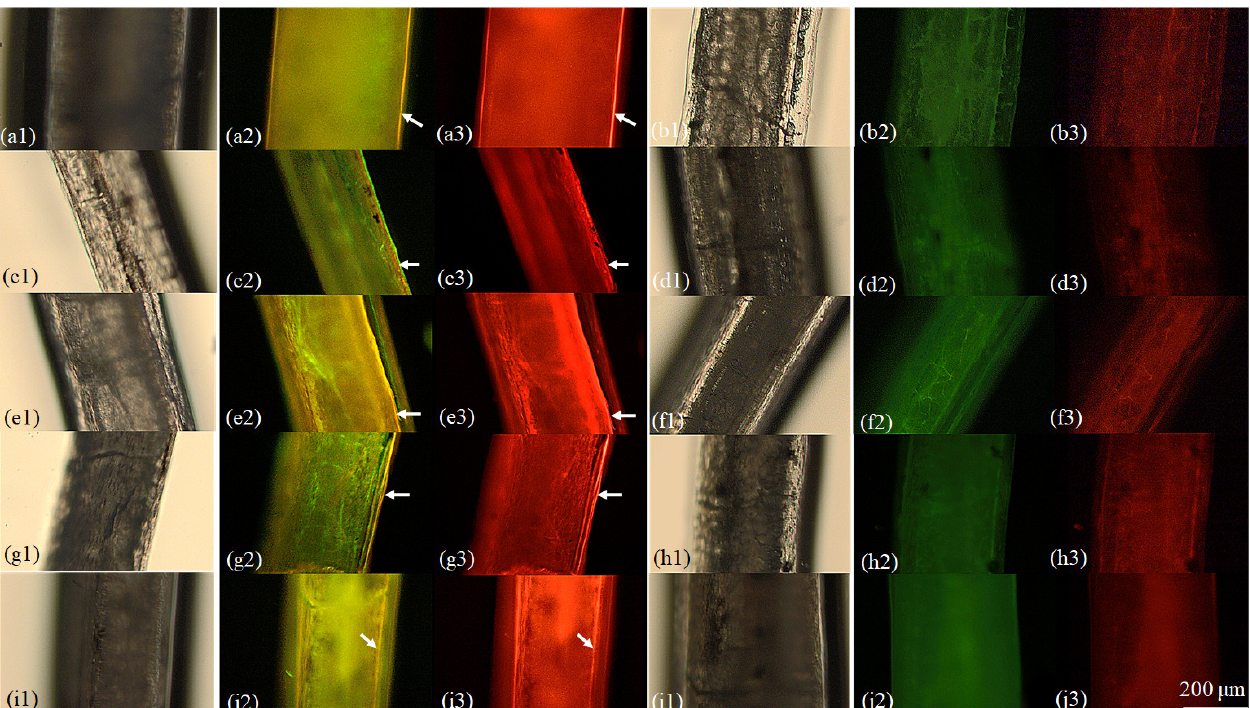
Figure 3. The typical patterns of marking when alizarin complexone (ALC) is used for marking fin rays in juvenile silver carp, Hypophthalmichthys molitrix . Note: ( a1 ), ALC-marked pectoral fin rays under transmitted light; ( a2 ), ALC-marked pectoral fin rays under blue excitation light; ( a3 ), ALC- marked pectoral fin rays under green excitation light; ( b1 ), control pectoral fin rays under transmitted light; ( b2 ), control pectoral fin rays under blue excitation light; ( b3 ), control pectoral fin rays under green excitation light; ( c1 ), ALC-marked dorsal fin rays under transmitted light; ( c2 ), ALC-marked dorsal fin rays under blue excitation light; ( c3 ), ALC-marked dorsal fin rays under green excitation light; ( d1 ), control dorsal fin rays under transmitted light; ( d2 ), control dorsal fin rays under blue excitation light; ( d3 ), control dorsal fin rays under green excitation light; ( e1 ), ALC-marked ventral fin rays under transmitted light; ( e2 ), ALC-marked ventral fin rays under blue excitation light; ( e3 ), ALC-marked ventral fin rays under green excitation light; ( f1 , control ventral fin rays under transmitted light; ( f2 ), control ventral fin rays under blue excitation light; ( f3 ), control ventral fin rays under green excitation light; ( g1 ), ALC-marked anal fin rays under transmitted light; ( g2 ), ALC-marked anal fin rays under blue excitation light; ( g3 ), ALC-marked anal fin rays under green excitation light; ( h1 ), control anal fin rays under transmitted light; ( h2 ), control anal fin rays under blue excitation light; ( h3 ), control anal fin rays under green excitation light; ( i1 ), ALC-marked caudal fin rays under transmitted light; ( i2 ), ALC-marked caudal fin rays under blue excitation light; ( i3 ), ALC-marked caudal fin rays under green excitation light; ( j1 ), control caudal fin rays under transmitted light; ( j2 ), control caudal fin rays under blue excitation light; ( j3 ), control caudal fin rays under green excitation light. The white arrows point to the fluorescent marks.